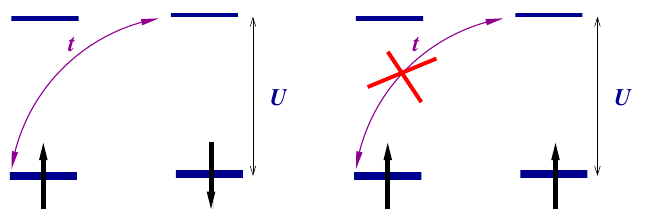
Figure 2. Description of the hydrogen molecule in the Heitler–London approach (account of